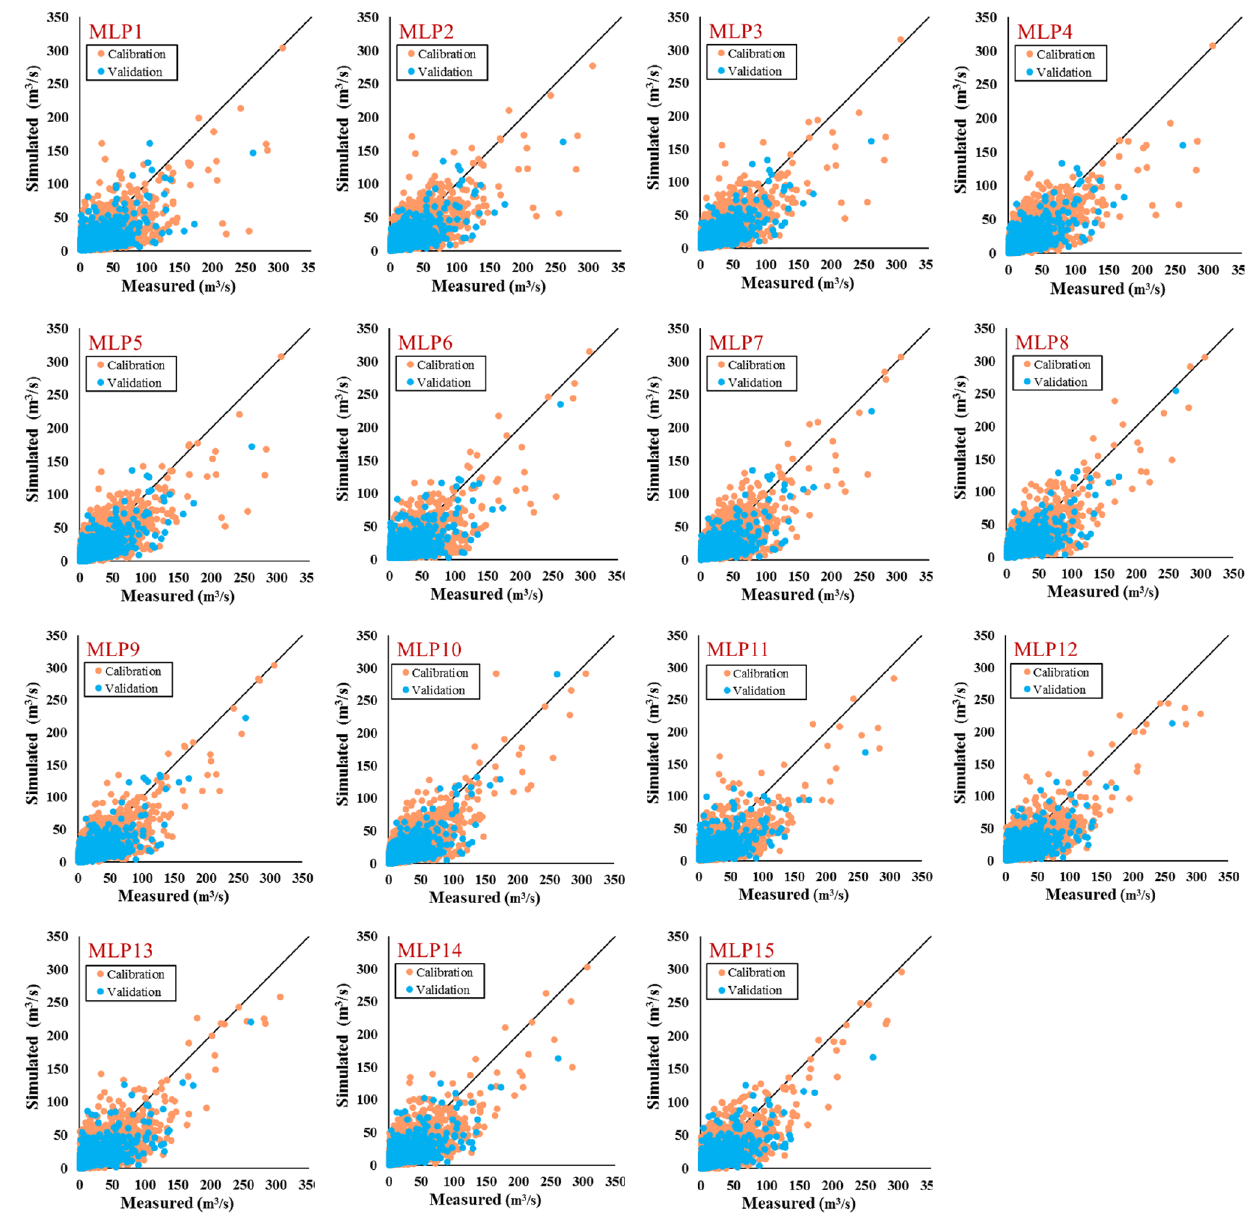
Figure 6. Scatter plots of measured vs simulated runoff for the calibration and validation phases through the different MLP